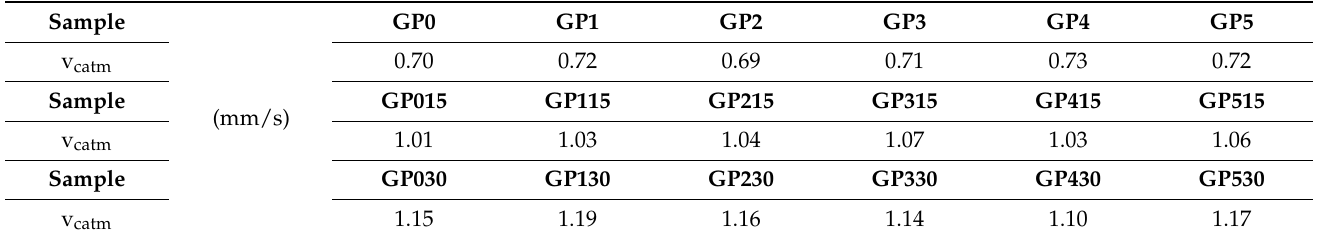
Table 6. Burning rates for each composition recorded at ambient